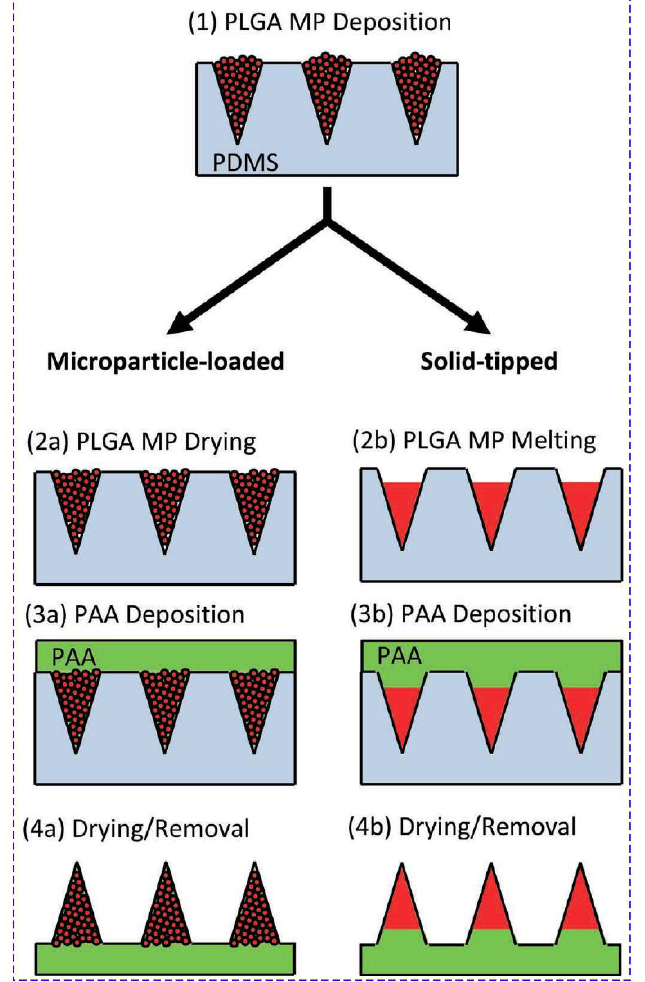
Figure 5. Schematic view of composite microparticle and bulk poly(lactic-co-glycolic) acid (PLGA) tip MN fabrication. Molds were first filled with PLGA microparticles (1). PLGA microparticles were then either dried in mold cavities (2a) or fused at a high temperature to create a solid tip (2b). Concentrated aq. poly(acrylic acid) solution was then centrifuged onto the filled molds to create a supportive matrix (3a) or pedestal (3b) for rapid dissolution in vivo. After drying, MNs were removed from molds (4a, 4b). Reprinted with permission from [117]. poly(lactic-co-glycolic) acid (PLGA), MP